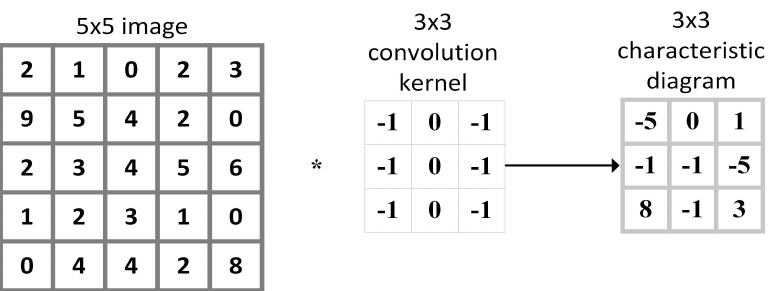
Figure 2. Convolution